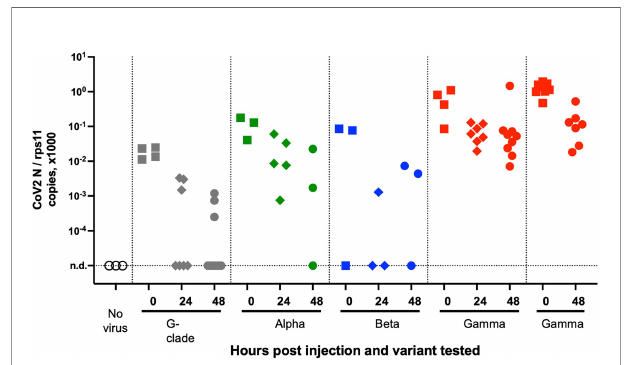
FIGURE 6 | Testing SARS-CoV-2 variants. qRT-PCR analysis of larvae at various times after injection of 2 nl of virus suspension in the swim bladder. Dotted lines separate independent experiments.